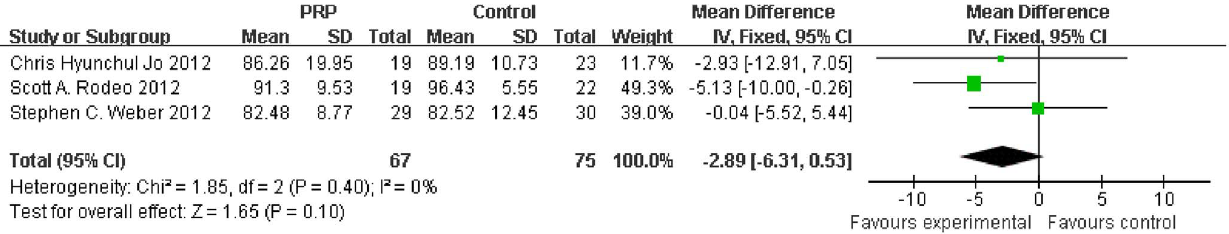
Figure 4. Difference in the ASES scale.